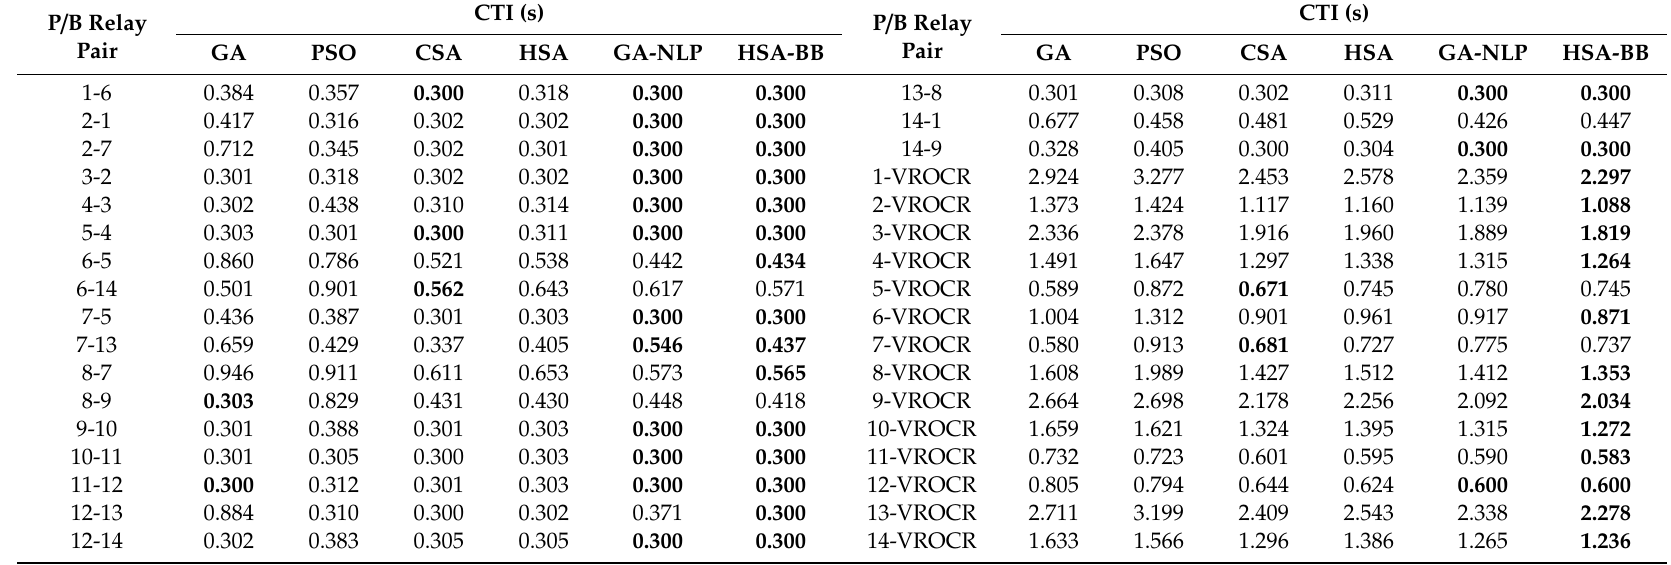
Table 5. Coordination time interval (CTI) values of P / B relay pairs for 8-bus